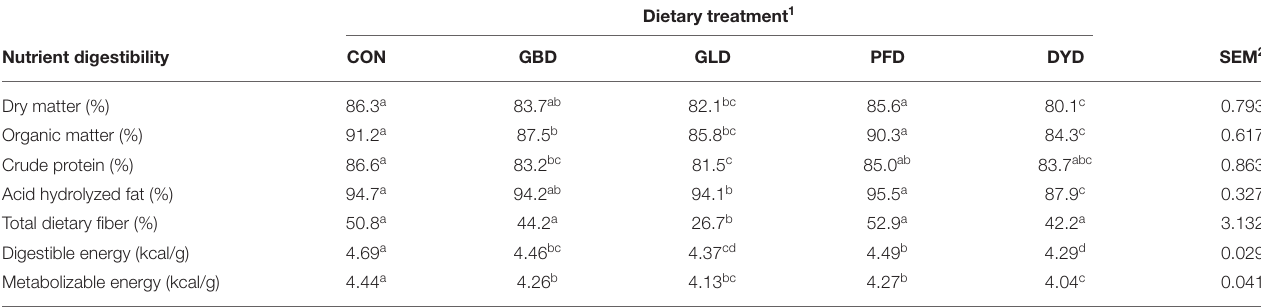
Dietary treatment